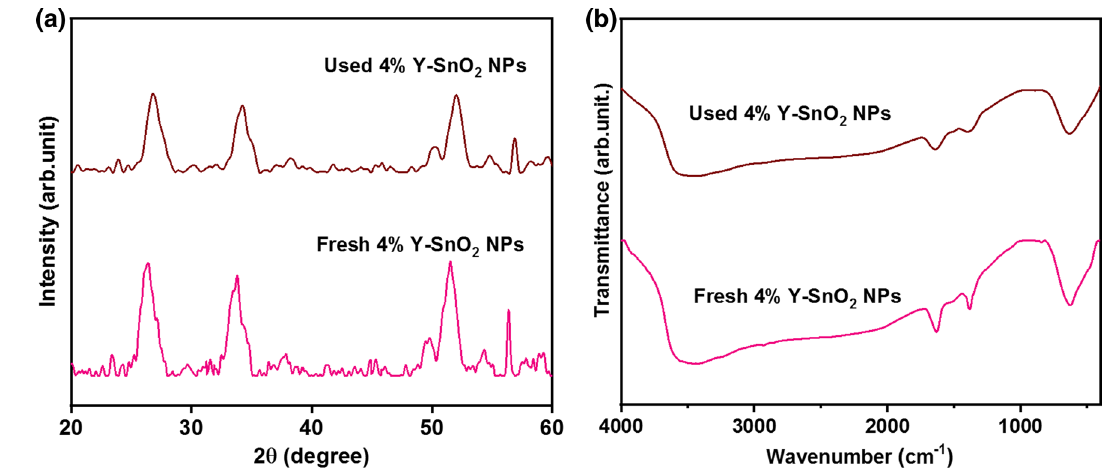
Fig. 12 XRD pattern and FTIR spectra for 4% Y-doped SnO